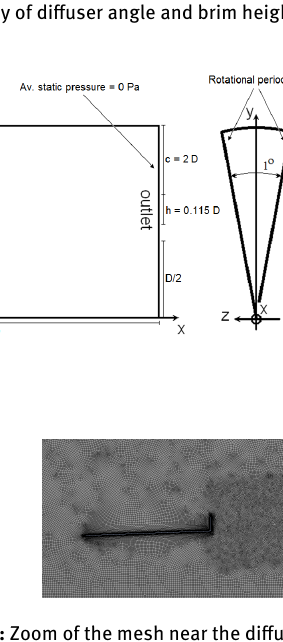
Figure 2: Zoom of the mesh near the diffuser